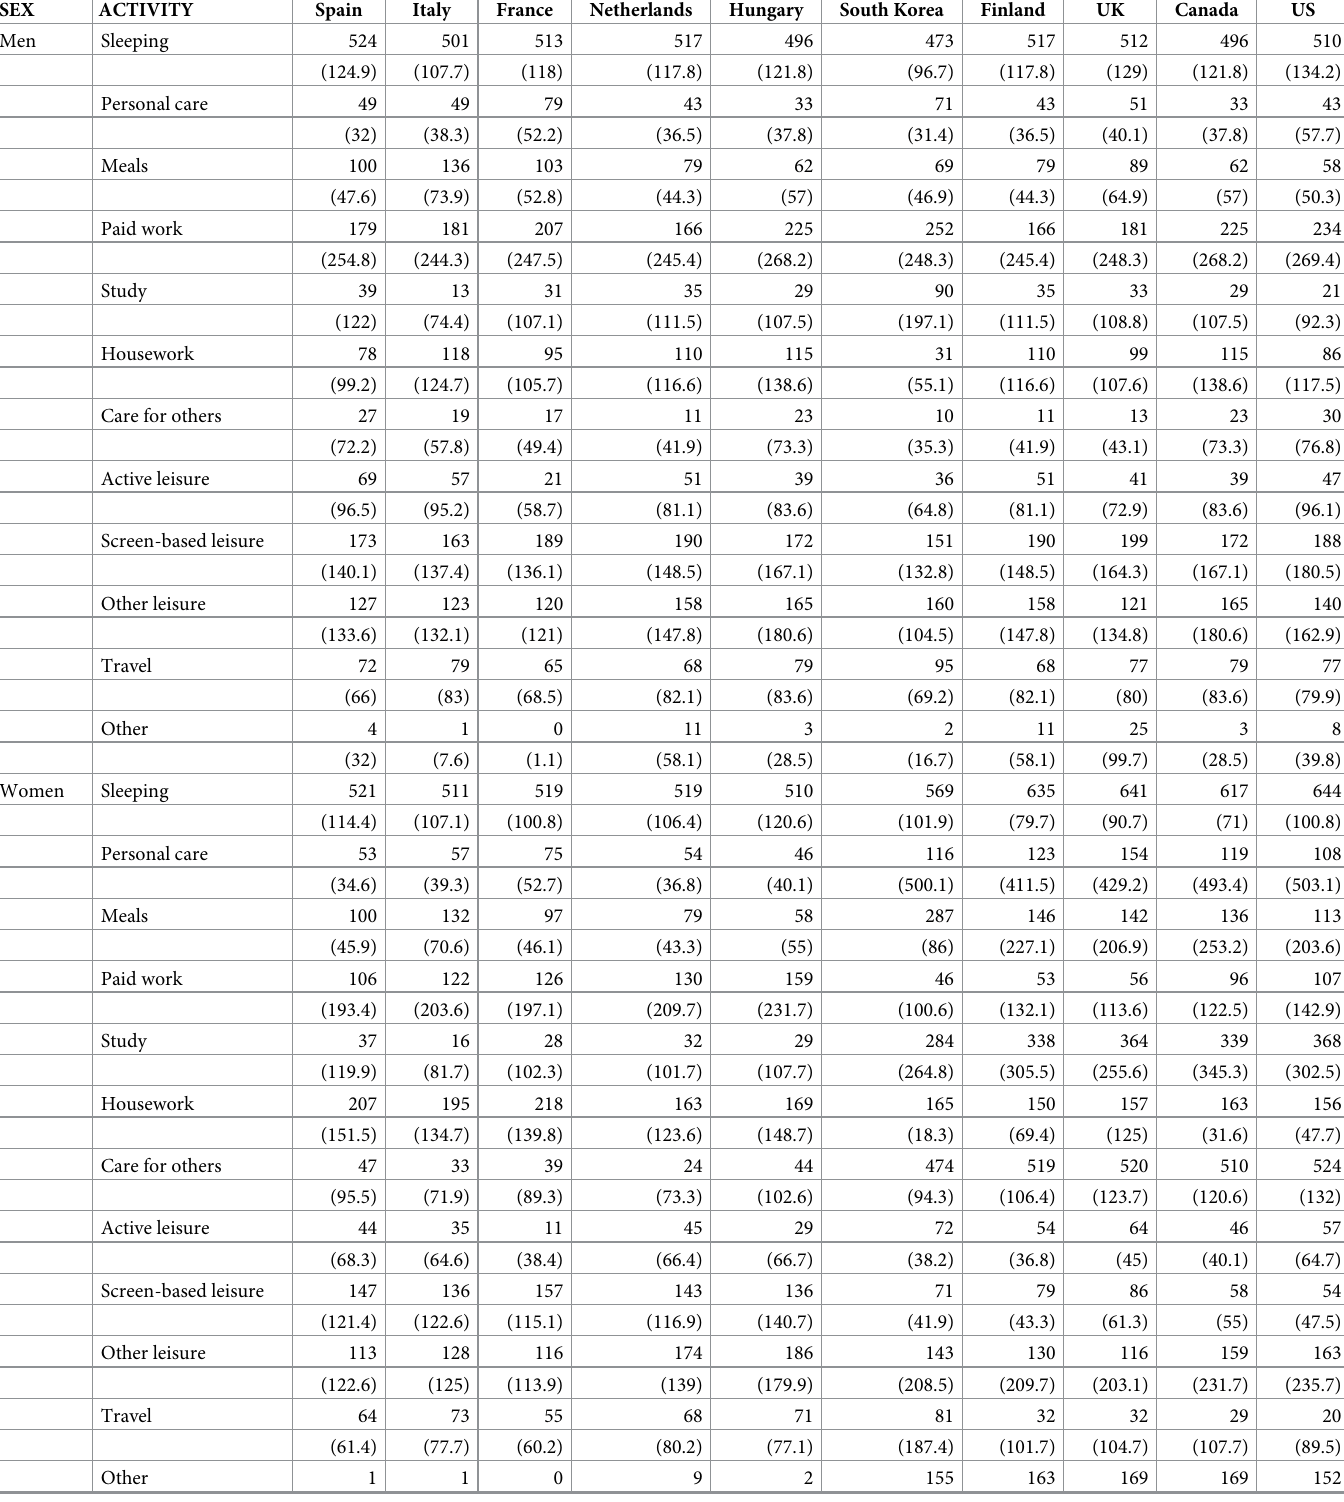
Table 1. Average time and standard deviation by activity. Men’s and Women’s daily minutes by